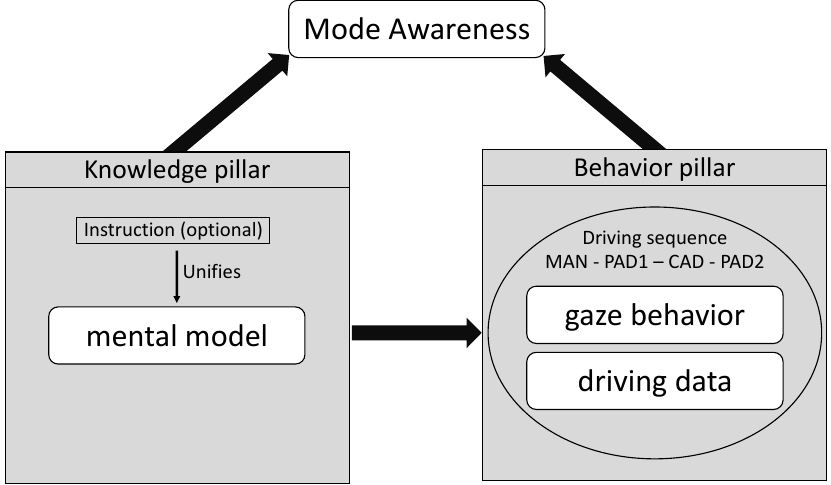
Figure 1. Mode awareness can be subdivided into a knowledge and a behavior pillar, which are measured separately in our proposed study design. All white frames represent dependent variables.